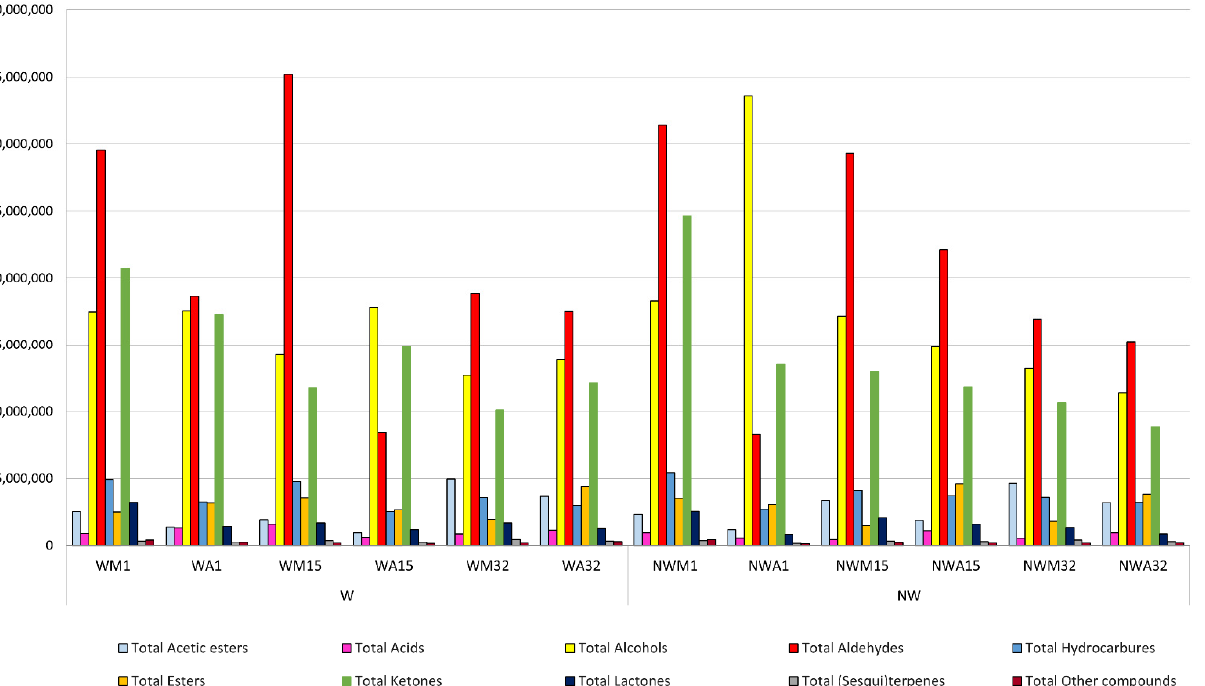
were placed on the upper and left side of the scores plot (negative values of PC1 and pos- itive values of PC2) and the samples collected during the morning (M) on the lower and right side (positive values of PC1 and more negative values of PC2). There was also a certain grouping according to the day of harvesting. According to the loadings (Figure 4b), one can see again the relationship discussed above between hydrocarbons, aldehydes, and lactones with the morning samples (M), such that almost all the volatile compounds of these families are in the positive side of PC1, where morning samples were positioned, while esters such as isopropyl palmitate were more related to the afternoon samples (A). However, no differences were observed between the washed or non-washed samples, confirming the results discussed above.